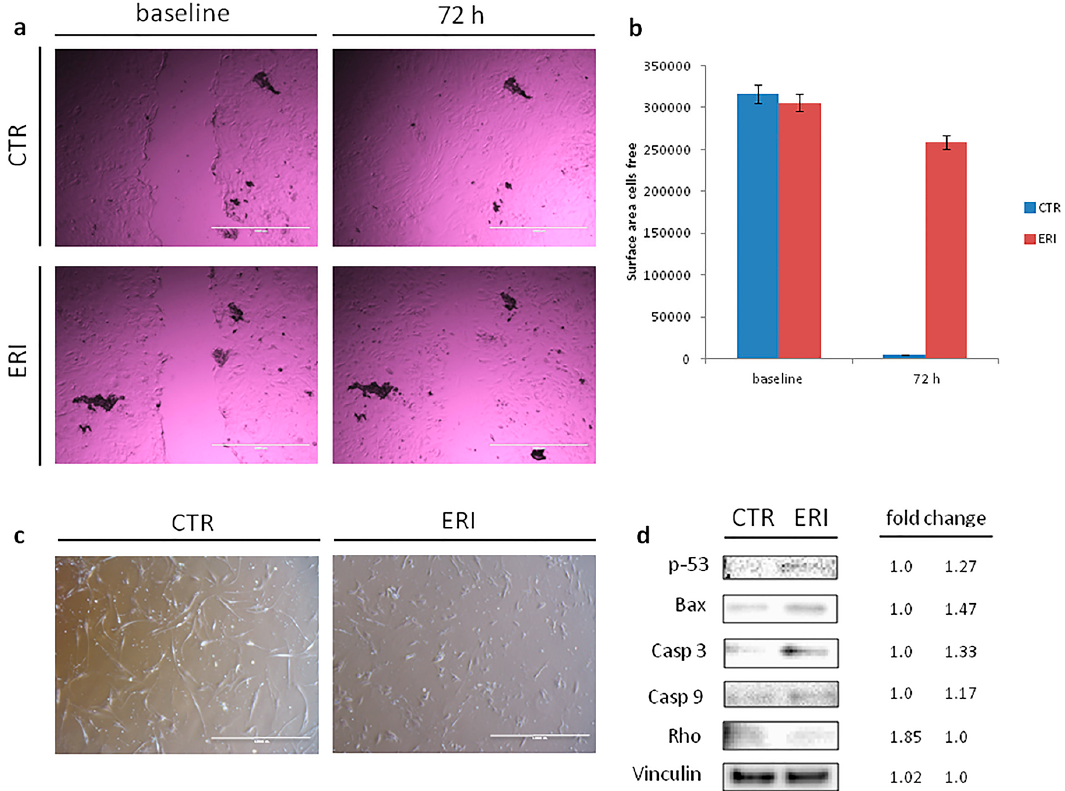
Figure 3. ( a ) Scratch wound assay. Wounds were generated after cell confluence. Cell migration and wound closure were assessed after 72 h, 4 × images of primary culture (control sample and treated sample) at baseline and after 72 h, scale bar 1000 µ m; ( b ) Areas of migration measured in the control sample and treated sample on days 0 and 3; ( c ) Morphological changes in the primary culture after eribulin treatment, 4 × images, scale bar 1000 µ m. After 72 h of treatment, eribulin induced a decrease in cell size, the cells lost some of the cytoplasmic architecture features, rounded up and were reduced in number; ( d ) Western blot analysis of apoptosis (p-53, Bax, Casp3 and Casp9) and migration-related proteins (Rho) and fold change in protein